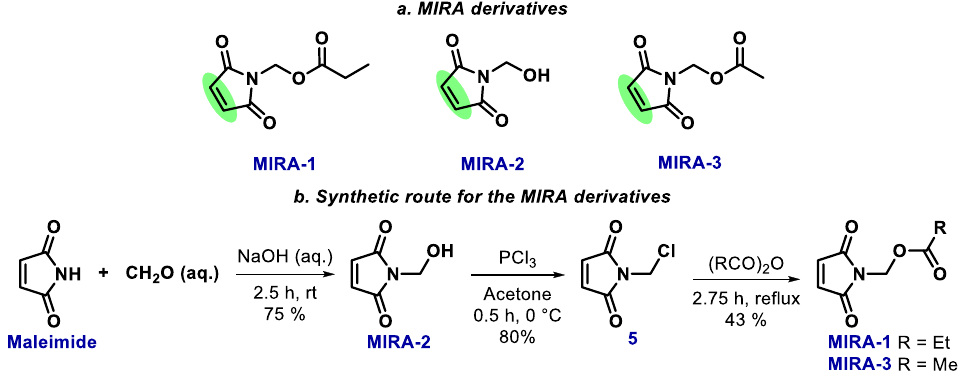
Figure 1. Structure of 3-benzoylacrylic acid derivatives reactivators of